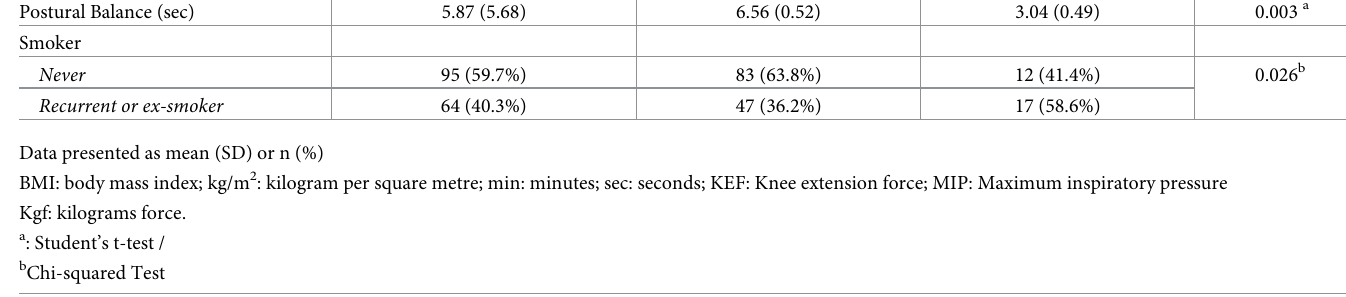
statistically significant difference (p = 0.026). No statistically significant difference between the groups was recorded for the variables BMI and physical activity. In Table 2 we can identify the characteristics of the participants associated with their bal- ance values ( � 2 or > 2 seconds). Women in the group with balance > 2 seconds were younger, with greater knee extension force and MIP > 80% of the predictive value; the p- values were statistically significant. When considering absolute values, the group with balance > 2 seconds presented higher mean MIP values (112.9 mmHg) than the MIP values achieved by the group with � 2 seconds (83.6 mmHg), p < 0.001. Likewise, a higher percentage of women with better balance reported that they had never smoked (64.6%), as compared to